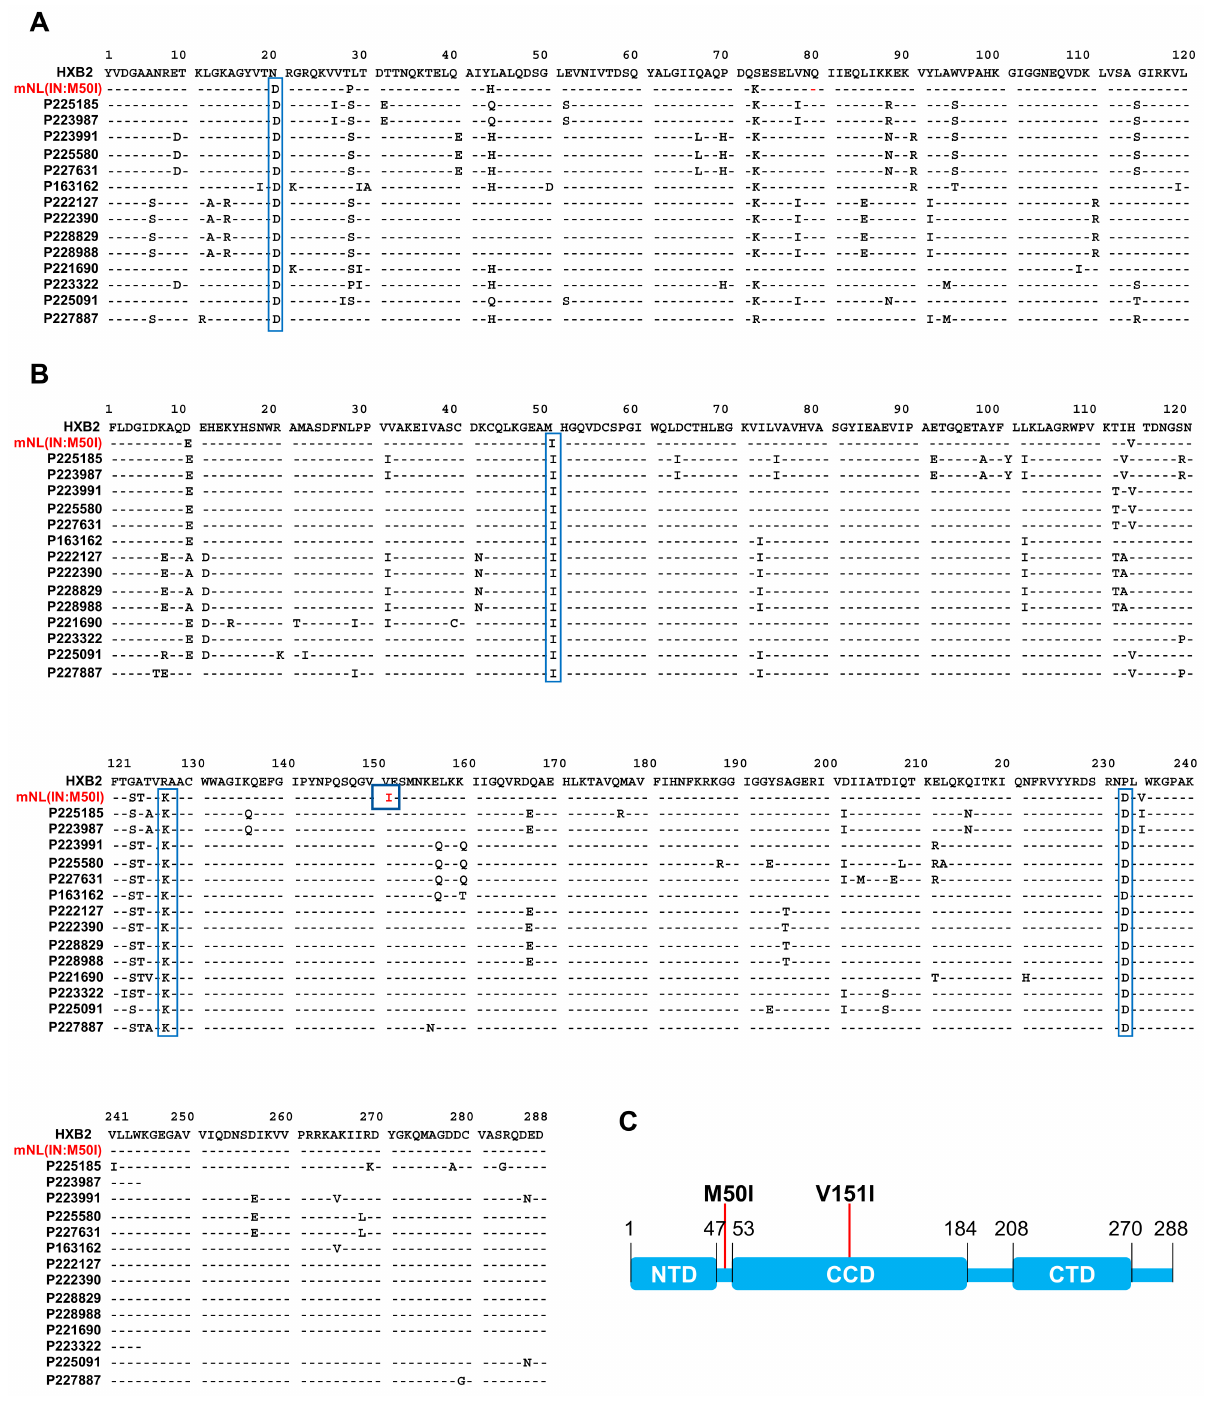
Figure 2. Amino acid Sequence Alignment of RH and IN. Amino acid sequences of RH ( A ) and IN ( B ) of 14 clones containing IN:M50I were aligned using the HIValign tool in LANL program (https://www.hiv.lanl.gov/content/sequence/ VIRALIGN/viralign.html, accessed on 28 September 2021). HXB2 sequence was used as a reference sequence in the alignment. The mNL4.3 sequence was also included in the alignment as a control. ( C ) A schematic diagram presents mature HIV-1 IN. IN is composed of the N-terminal domain (NTD) (codons 1–49), the catalytic core domain (CCD) (codons 50–212) and the C-terminal domain (CTD) (codons 213–288)